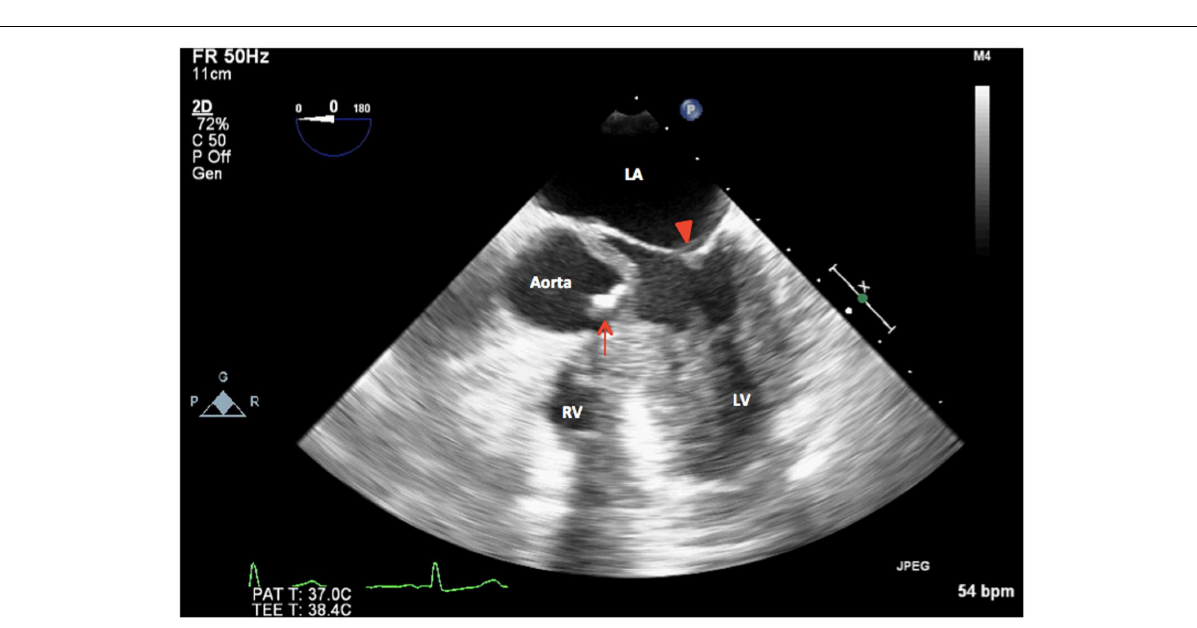
( Figure 5 ). The ascending aorta was also dilated and measured 41 mm at the level of the right pulmonary